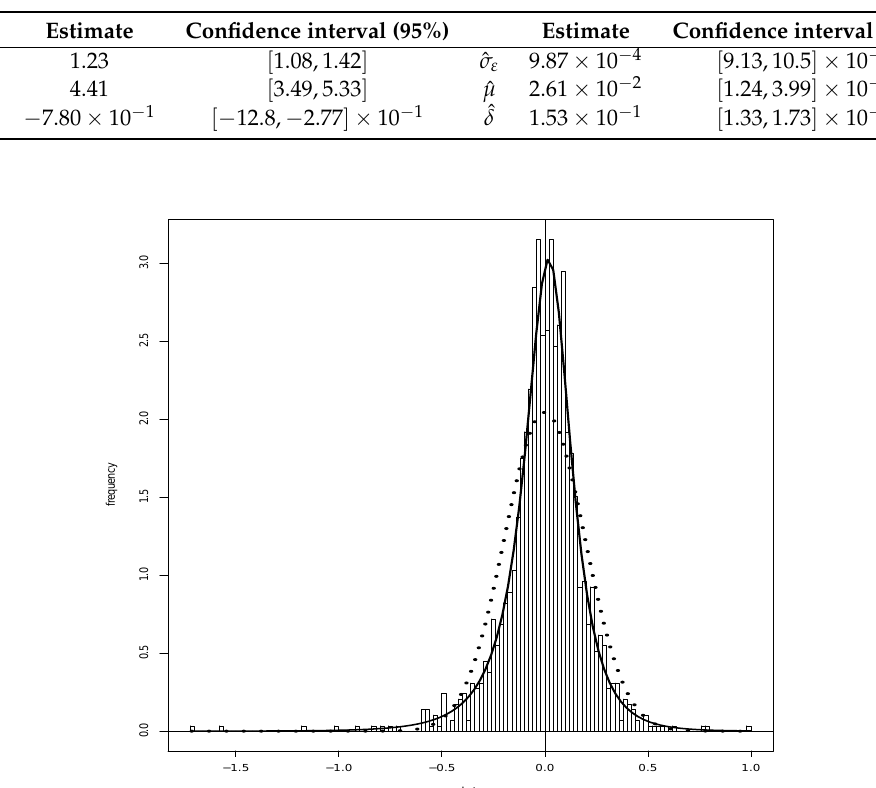
Figure 3. The estimated NIG (bold line) and Gaussian (dotted line)